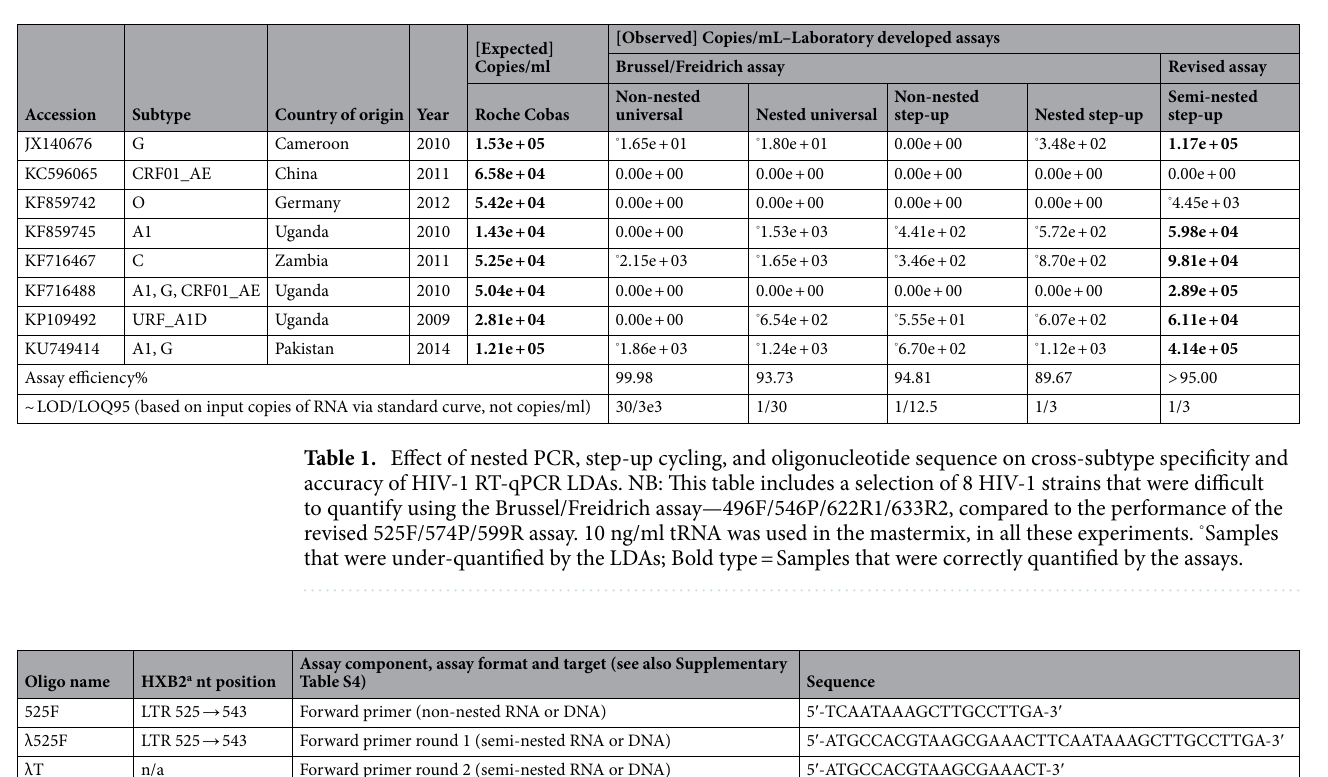
Table 2. Oligonucleotides designed and tested for various formats of the HIV-1 assay. a Genbank Accession ID K03455. Inosine and mixed bases shown in enlarged bold font. AlleleID 7.0 and IDT Oligoanalyzer software